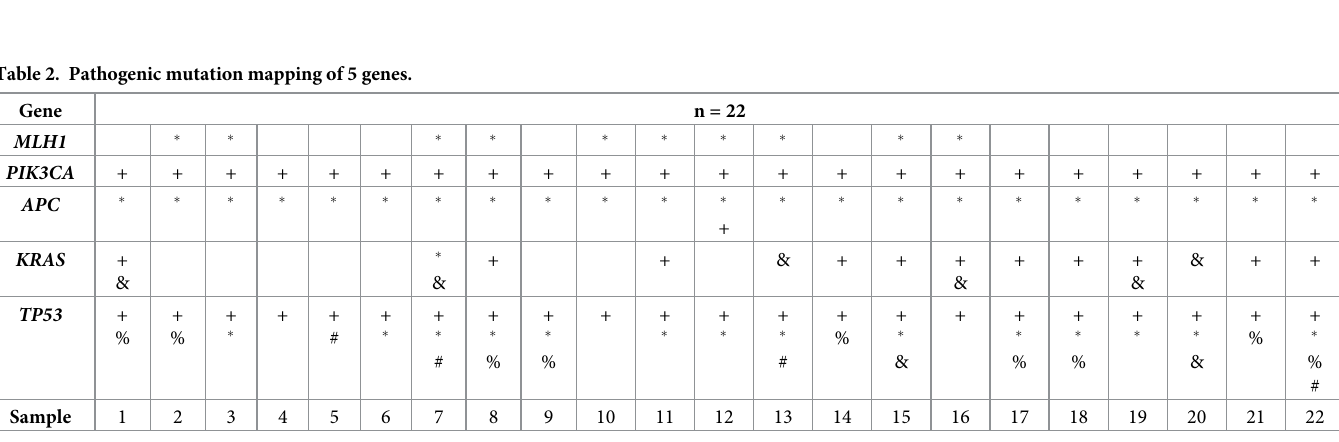
Table 2. Pathogenic mutation mapping of 5